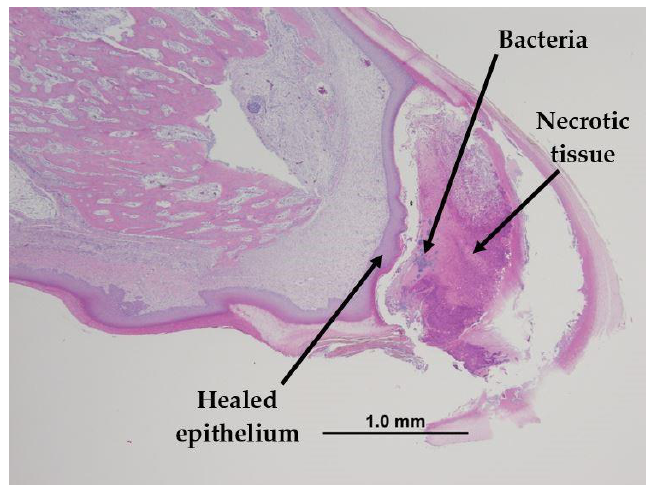
Figure 5. Histological section of the top beak of an IR pullet at 1 day post treatment (score of 4). The beak tissue below the treatment line is dead (coagulative necrosis) but still intact. Cellular infiltration, edema, and hemorrhage are present. H&E staining. Magnification 4×.